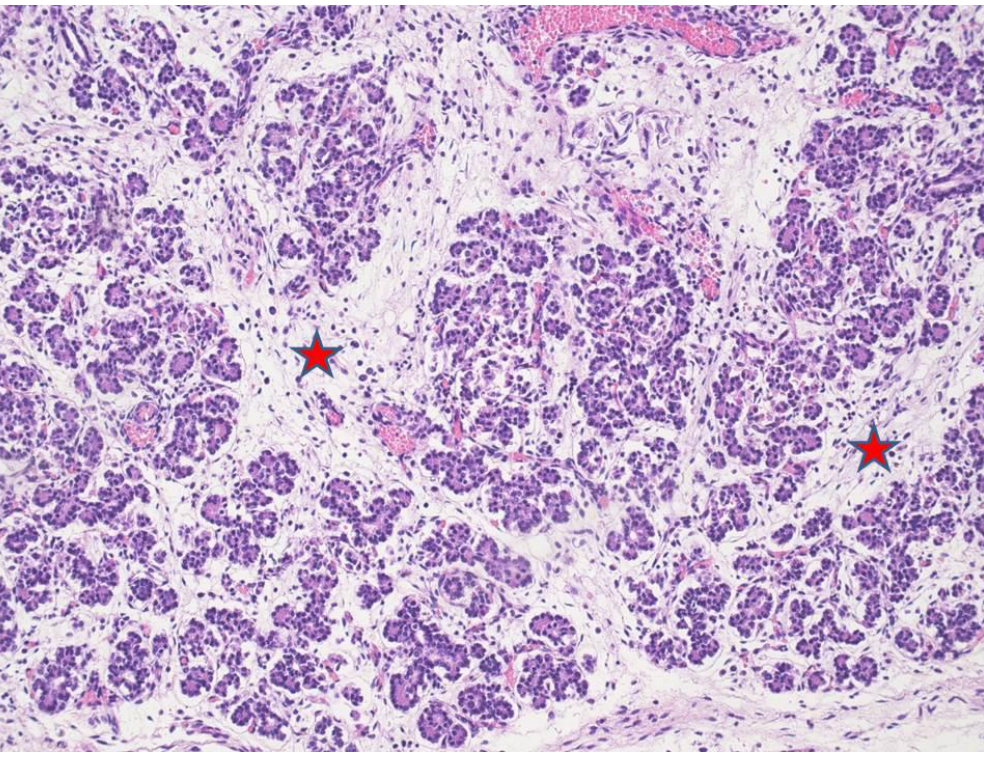
Figure 3. Pancreatic acini with interacinar edema (red stars) (HE staining 4×). Postmortem lung and blood cultures were processed according to routine procedures on selective media. Identification was performed by MALDI-ToF MS (MALDI Biotyper , Bruker Daltonik GmbH, D-28359, Bremen, Germany), while for susceptibility testing, the Phoenix 100™ system was used (Becton, Dickinson and Company, Franklin Lakes, NJ, USA) and agar diffusion (Kirby–Bauer method, according to EUCAST rules). The isolate was identified as K. pneumoniae ssp. pneumoniae . Further phenotypical test, performed according to Brisse et al., allowed for setting the isolate in the K. pneumoniae phylogroup KpI [17].